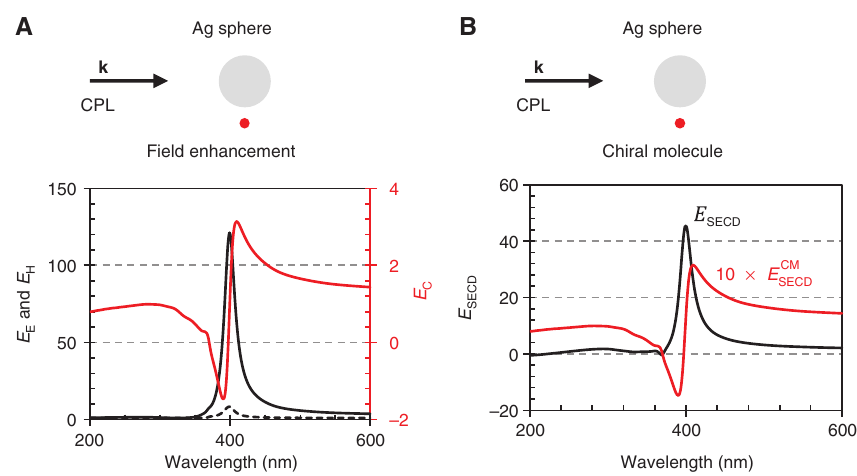
= | E | 2 / | E | 2 , black solid) and magnetic field enhancement ( E E 0 (red solid) in the absence of CM. (B) CD enhancement factor of the NP-CM complex ( E C